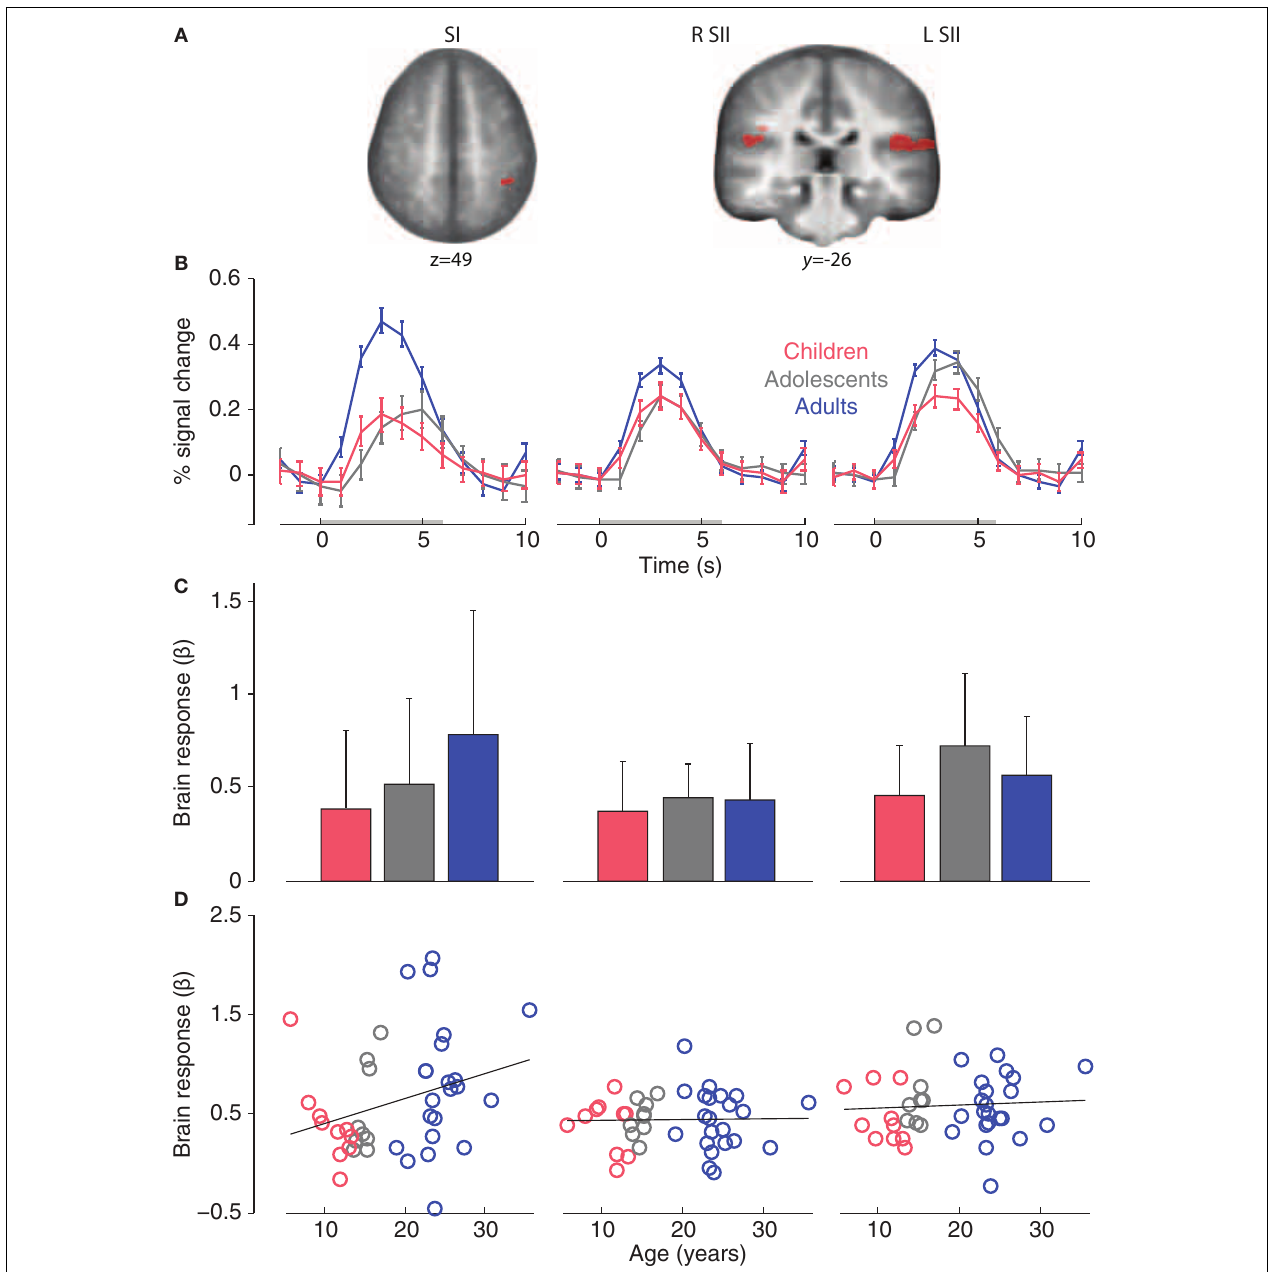
FIGURE 3 | (A) Adult somatosensory ROIs for main effect of touch (Arm touch + Palm touch > Rest, p < 0 . 001, k = 12). (B) Group mean ROI event-related brain responses (to Arm touch + Palm touch). (C) Group mean ROI-average